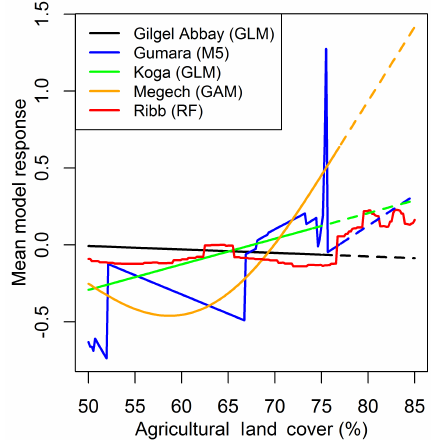
Figure 7. Partial dependence plot for agricultural land cover in the highest performing model in each basin. Model type is listed in parentheses for each basin. Dashed lines indicate values that exceed historic levels of agricultural land cover experienced in that